Question: What type of chart is this?
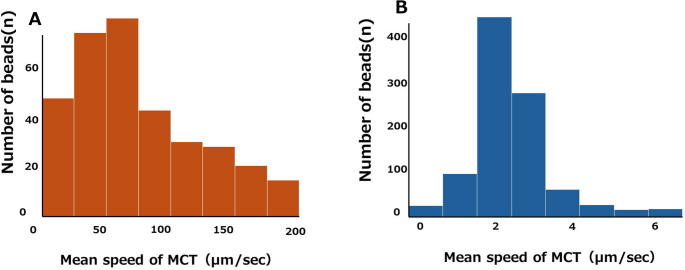
Answer: histogram